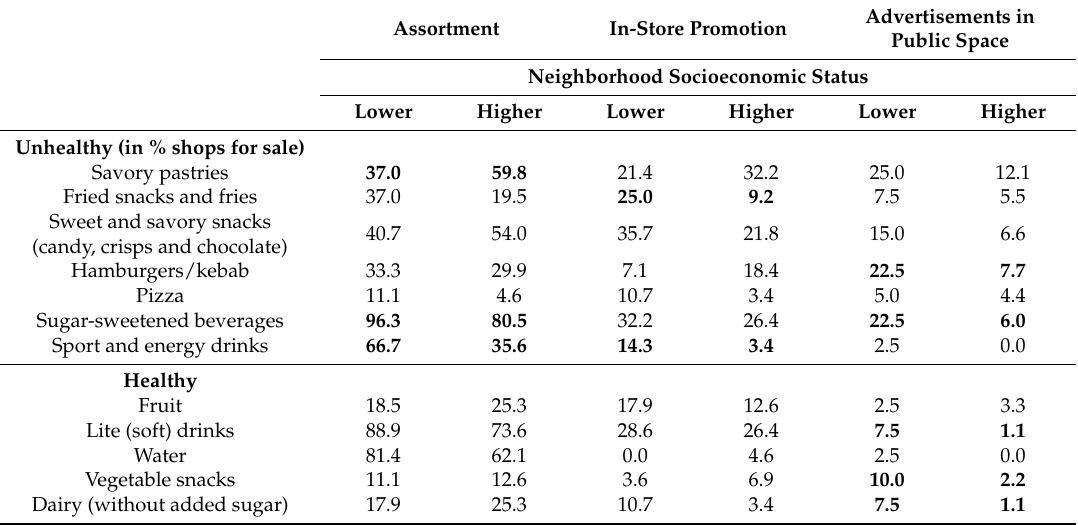
Table 3. Differences in ready-to-eat food assortment, discounts and advertisements for commercialization and neighborhood socioeconomic